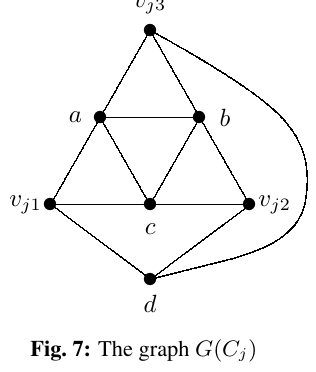
Fig. 7: The graph G ( C j